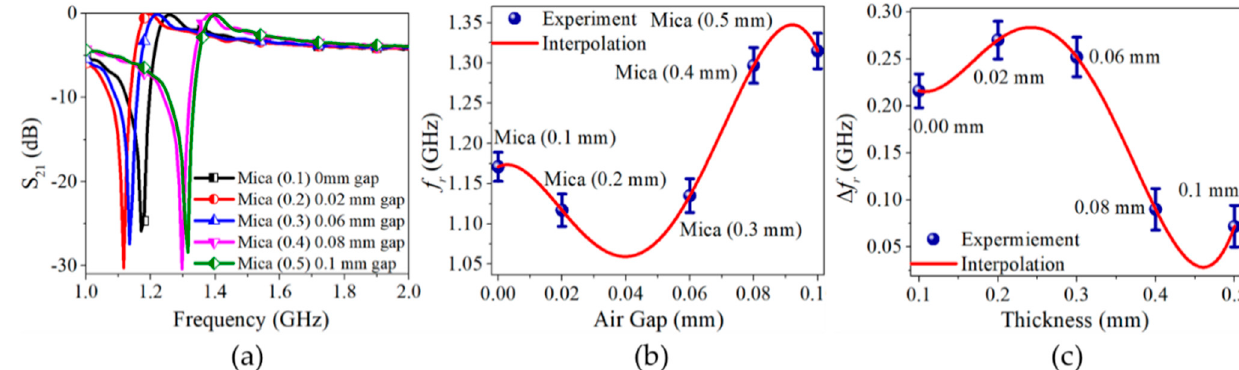
Figure 8. ( a ) |S 21 |measured analysis of different thicknesses of mica MUT loaded on the high e-field centralized IDC structure with varying air gaps; ( b ) resonance frequency; and ( c ) frequency shifting (note: Equations (20) and (21) based on Figure 8b,c were arbitrarily proposed).